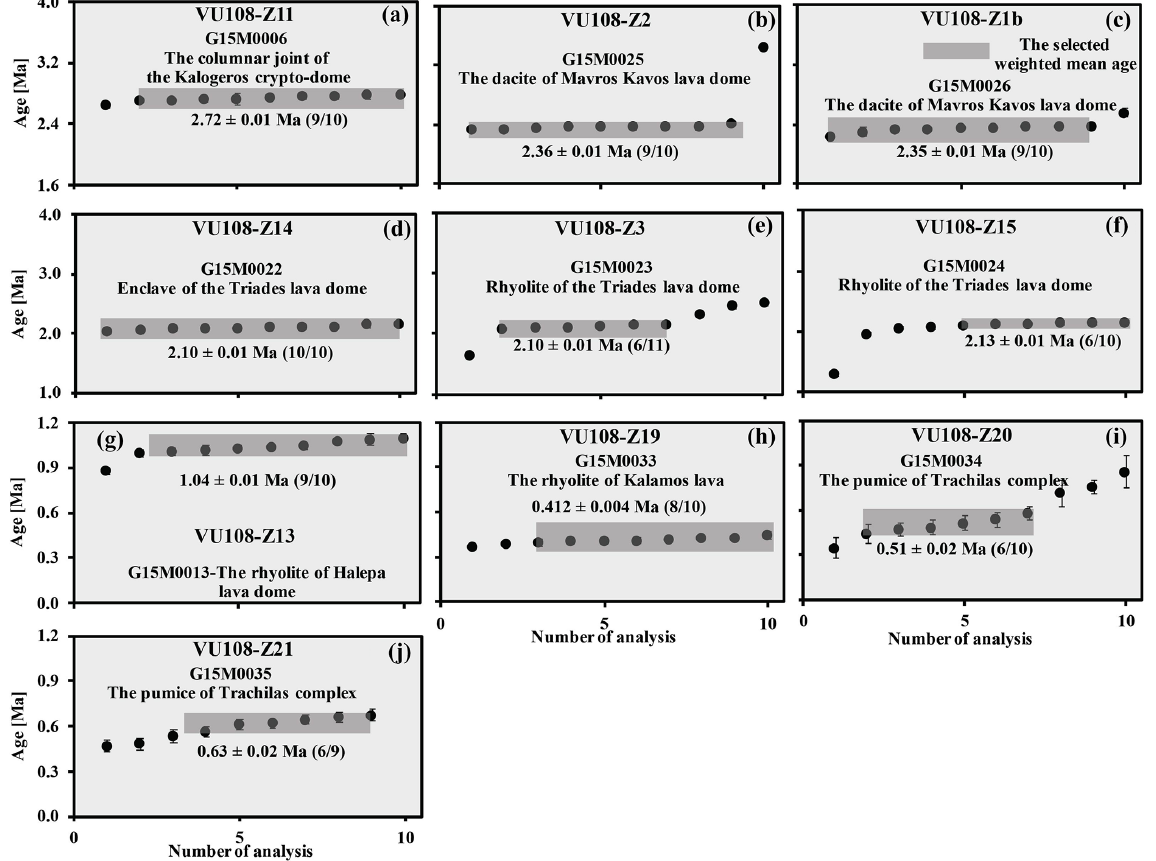
Figure 7. Biotite 40 Ar / 39 Ar total fusion ages for samples G15M0006 (a) and G15M0025-26 (b,c) , G15M0022-24 (d–f) , G15M0013 (g) and G15M0033-35 (h–j) . Data outside the shaded area are not included in the weighted mean. Individual steps and final age calculation are reported with 1 σ errors. The Kalogeros crypto-dome and Mavros Kavos lava dome are located in the north-eastern and south-western parts of the Milos VF, respectively, and the Triades lava dome, Halepa lava dome, Trachilas complex and Kalamos lava are situated in the southern, northern and south-eastern parts of the Milos VF (see Fig.